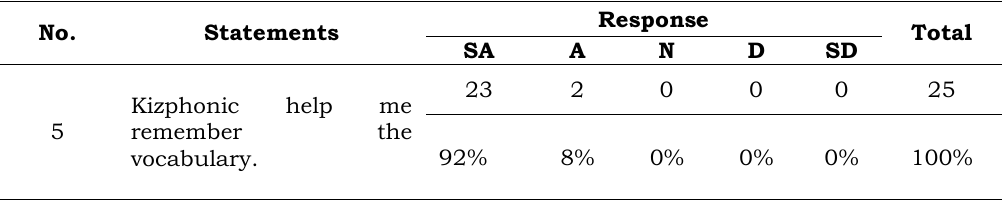
Table 7. Response to the questionnaire number